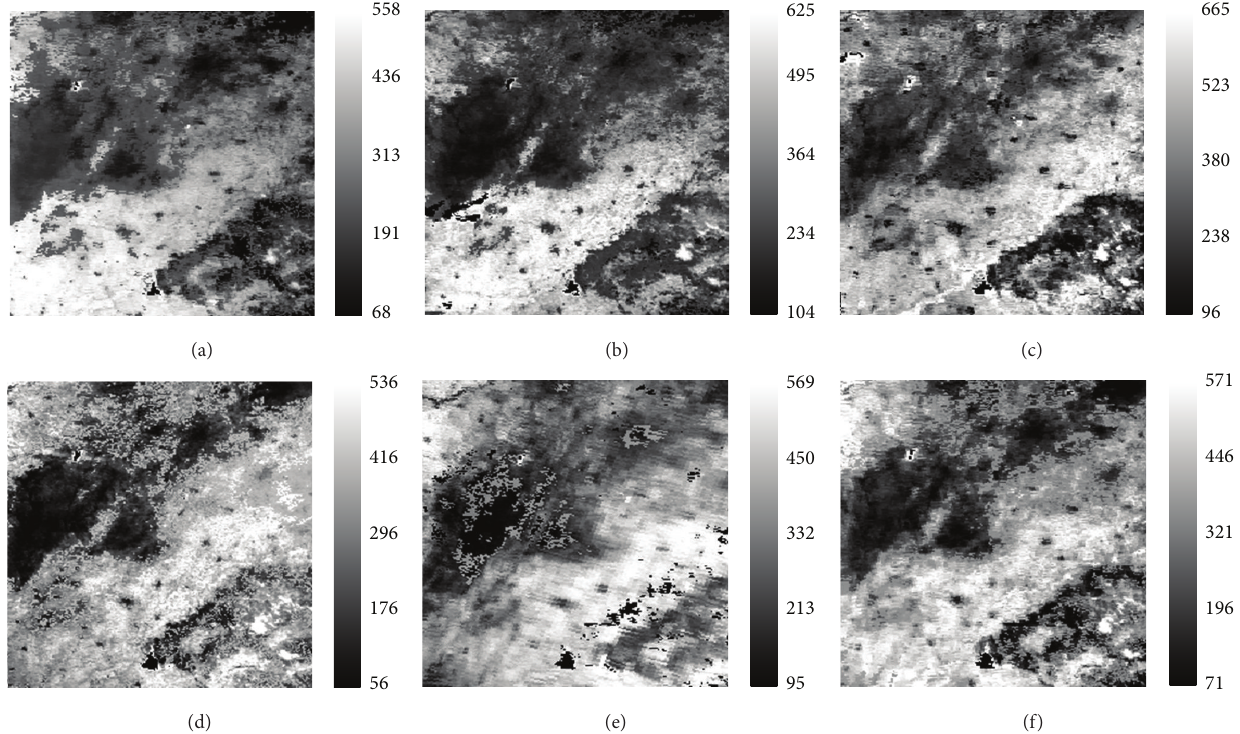
Figure 3: The available MDREs retrieved from the Aqua data at 14:30 local solar time in May, 2005. (a) The MDRE on May 2, 2005; (b) the MDRE on May 7, 2005; (c) the MDRE on May 14, 2005; (d) the MDRE on May 19, 2005; (e) the MDRE on May 25, 2005; (f) the MDRE on May 31,